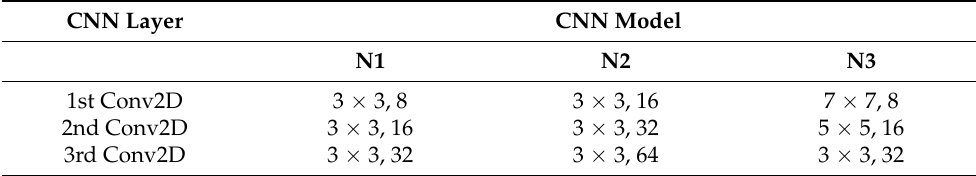
Table 3. Functional description of convolution layers for N1, N2, and N3